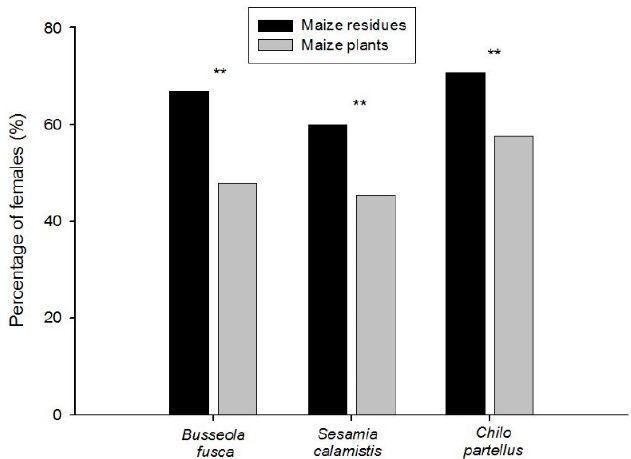
Figure 4. Percentages of females of Busseola fusca , Sesamia calamistis , and Chilo partellus found in the maize residue habitat during the non-cropping seasons and on maize plants in the cultivated habitat during the subsequent cropping seasons. The proportion of males and females was set to 100% to calculate the percentage of females. The proportions of males and females were compared between habitats for each species using a two-tailed Fisher’s exact probability 2 × 2 test (**: p < 0.01). Before parasitoid release, C. flavipes or C. sesamiae were not recovered from either maize plants, maize residues, or wild plants in Makutano and Murang’a (Figure 5). Three parasitoid species ( Syzectus sp., Pediobius furvus , and Siphona sp.) were recorded, mostly in wild plants, of which only Pediobius furvus was present in maize residues and maize fields (Figure 5). After and during the releases, C. flavipes and C. sesamiae were recovered mostly from maize plants during subsequent cropping seasons and maize residues during non-cropping seasons (Figure 5).